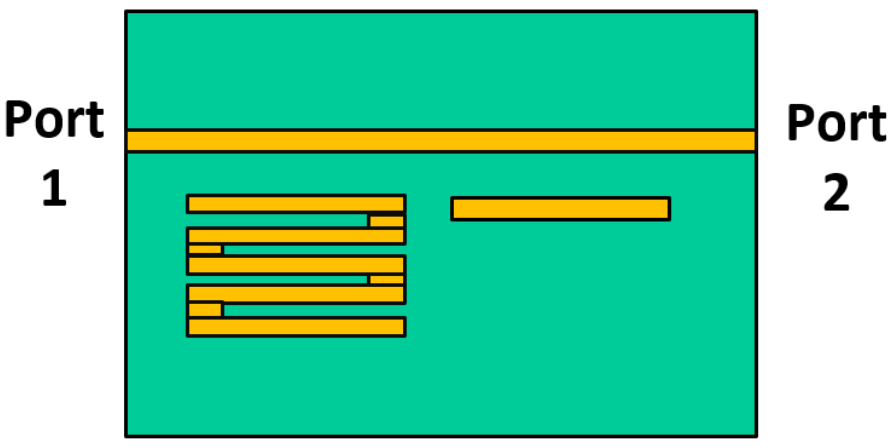
Figure 15. Photograph of the Microfluidic impedance tuner.